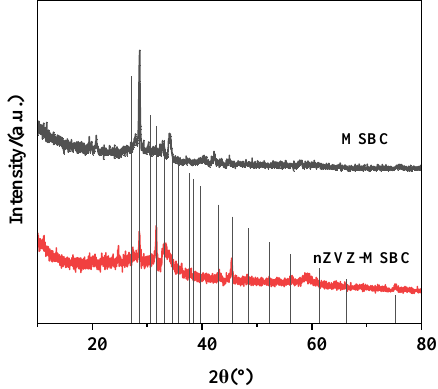
Figure 3. XRD results of MSBC and nZVZ–MSBC.